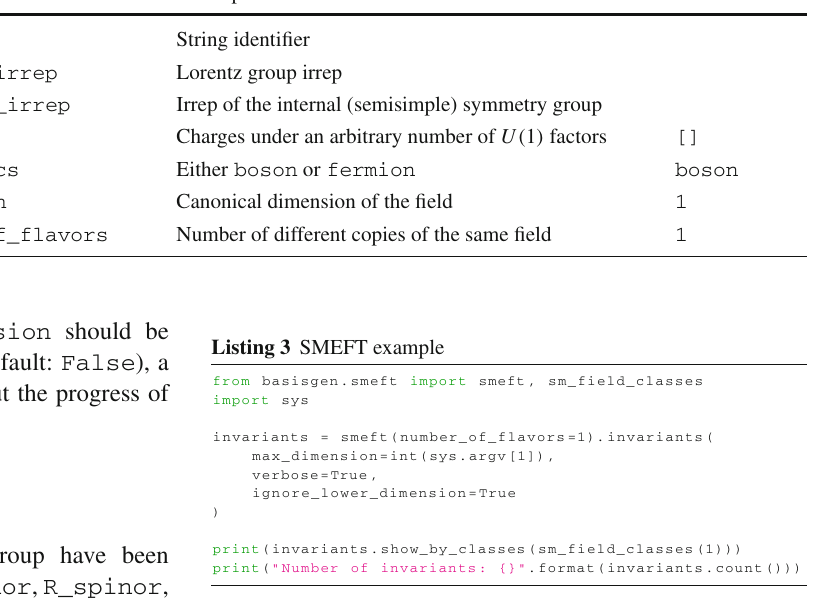
Table 1 Arguments of the Field constructor